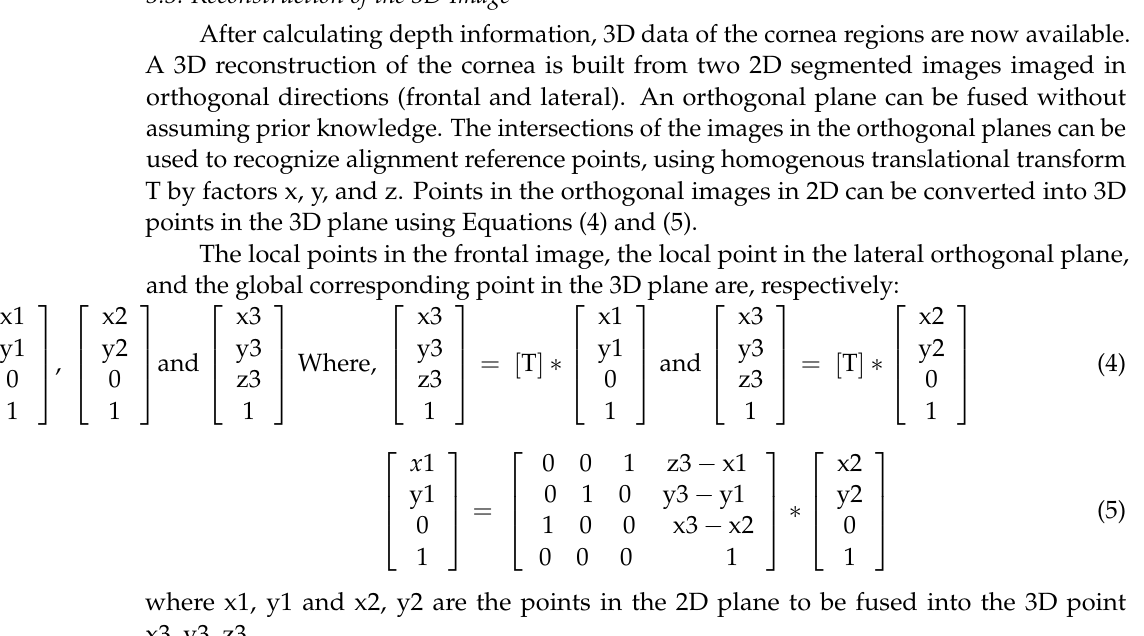
Figure 6. Lateral view of the cornea.